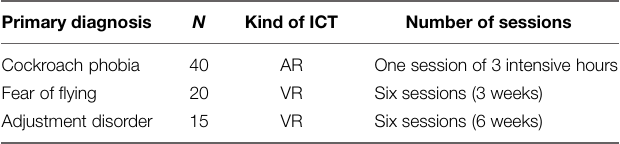
TABLE 1 | Clinical characteristics of the sample and